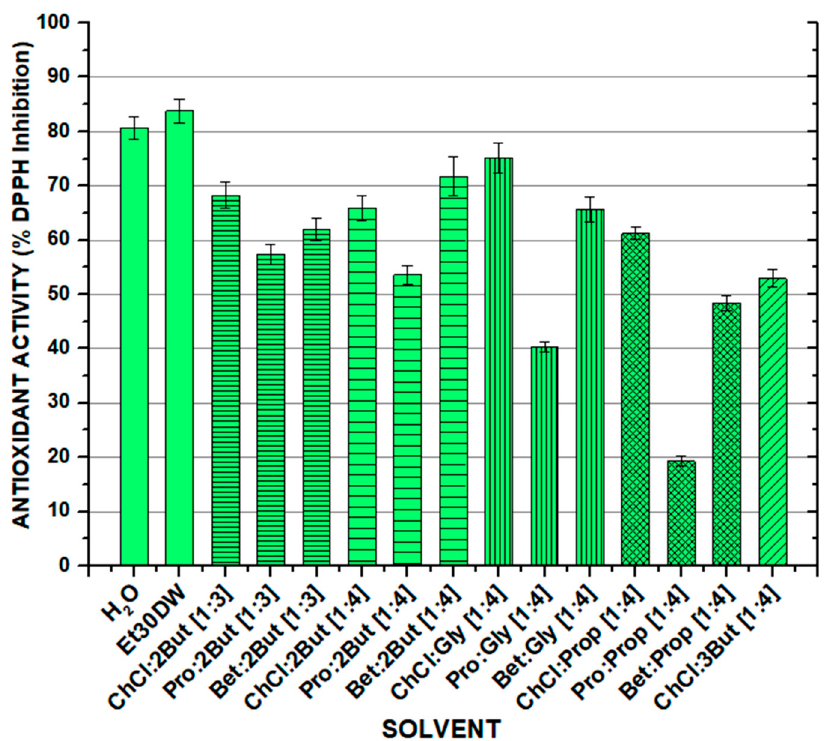
Figure 2. Antioxidant activity (expressed as % DPPH inhibition) of the solvent extracts obtained after the solid–liquid conventional extraction process from a white grape waste sample. OSE conditions: 100 min at 900 rpm, 60 °C, and 1:10 F:S ratio.